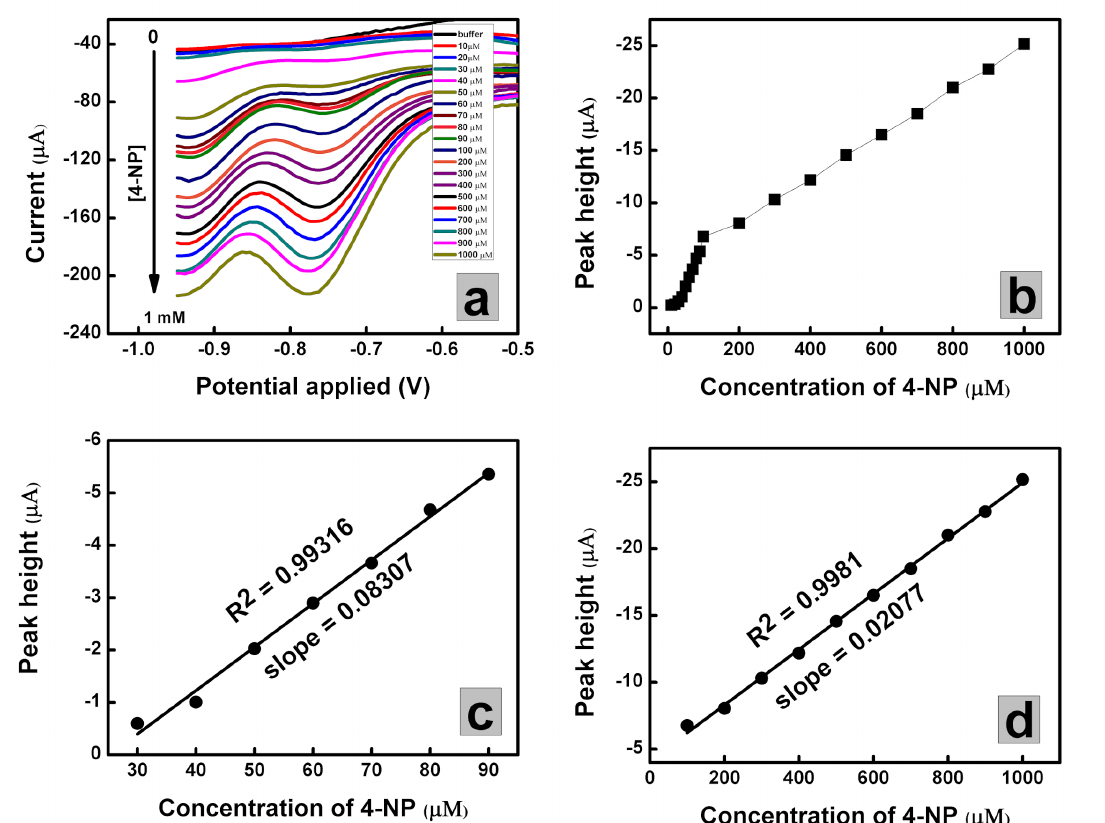
Fig.10. DPVs of ( Gr-Ag-20/PNA/CPE)/CPE with increasing 4-NP concentrations (1- 1000 µM) in phosphate buffer solution against Ag/AgCl as reference electrode at